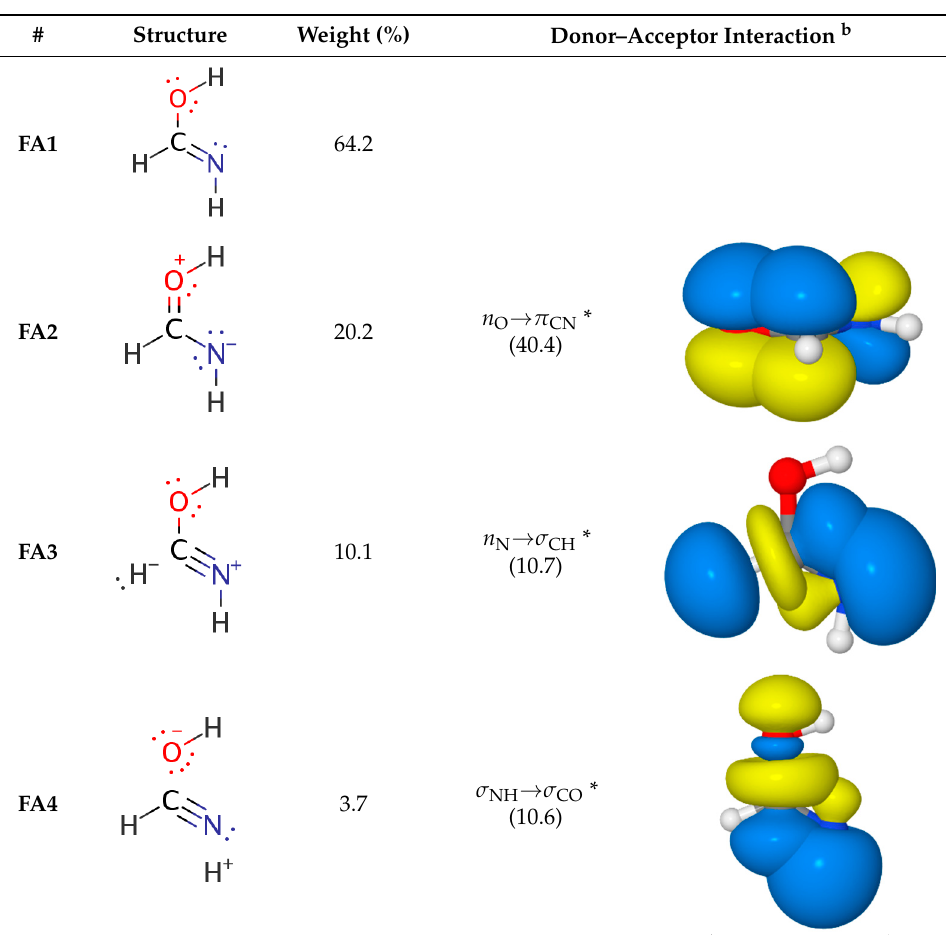
Figure 5. Natural bond orders and optimized bond lengths (in parentheses, in Å) for formamide and formimidic acid.